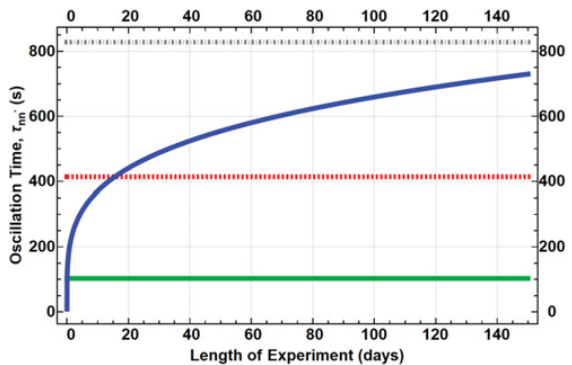
Figure 7. Number of neutrons as a function of storage time in the PSI nEDM apparatus compared to the storage curve of Ref. [22] at the ILL. Solid blue curve, with blue dots for data points, indicates the storage curve measured at PSI for unpolarized UCNs. The dashed red curve, with red squares for data points, shows the storage curve measured at ILL for unpolarized UCNs.